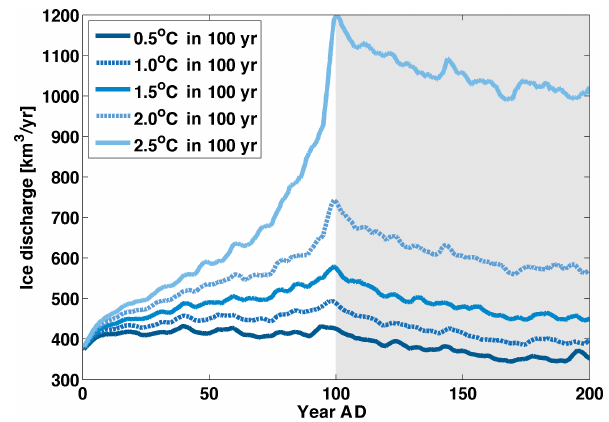
Figure 2. Ice discharge response to a linear increase in ocean tem- perature. The atmospheric forcing is unchanged and based on the SMB of one climate model (i.e. 2005 MPI-ESM-LR). Ocean tem- perature increase is linear for 100 years and is then kept at the same